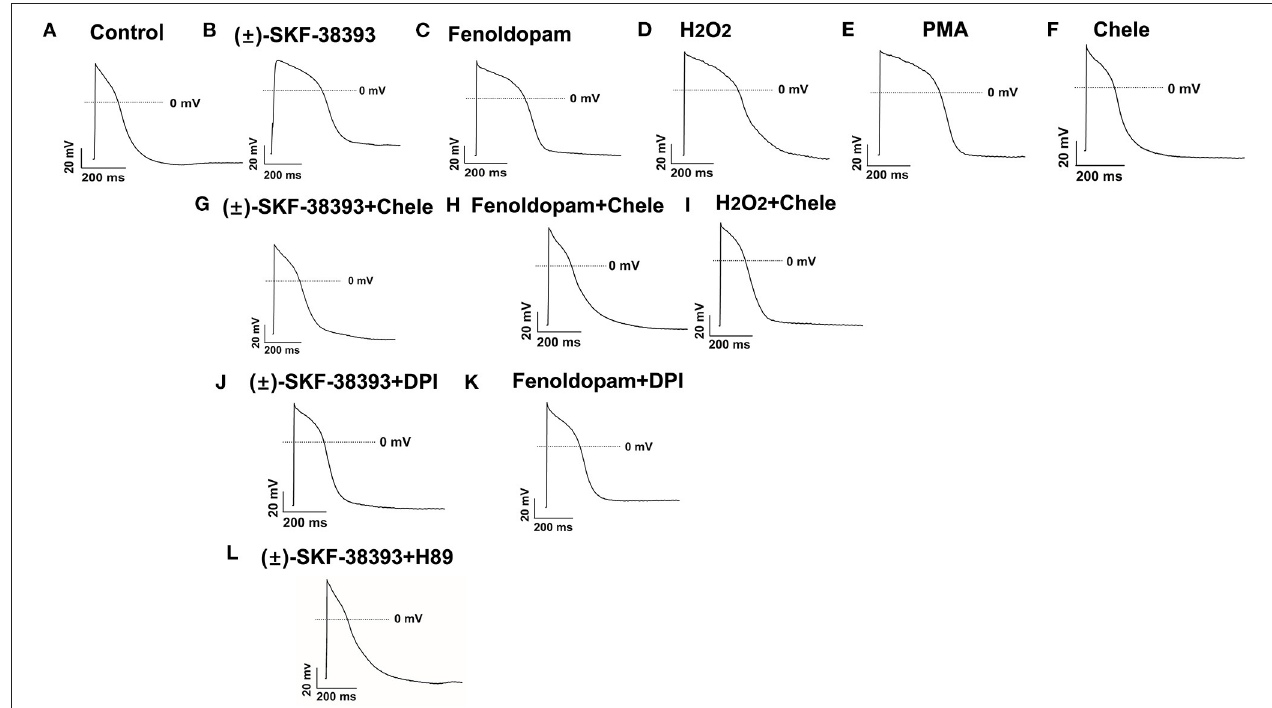
FIGURE 6 | Protein kinases and NADPH oxidases participating in dopamine D1/D5 receptor and ROS signaling. hiPSC-CMs were challenged for 1h by vehicle [Control, (A) ] or 50 µ M ( ± )-SKF 38393 (B) or 5 µ M fenoldopam (C) or 100 µ M H 2 O 2 [H 2 O 2 , (D) ] or 10 µ M PKC activator PMA [PMA, (E) ] or 10 µ M Chele (F) or ( ± )-SKF 38393 plus 10 µ M chelerythrine (Chele), an inhibitor of protein kinase C (G) , or fenoldopam plus Chele (H) or H 2 O 2 plus Chele (I) or ( ± )-SKF38393 plus 10 µ M DPI (J) or fenoldopam plus DPI (K) or ( ± )-SKF 38393 plus 1 µ M H89, an inhibitor of protein kinase A (L) . Action potentials paced at 1Hz were recorded. Statistical data are summarized in Table 3 . (A–L) Examples of AP-traces in each group